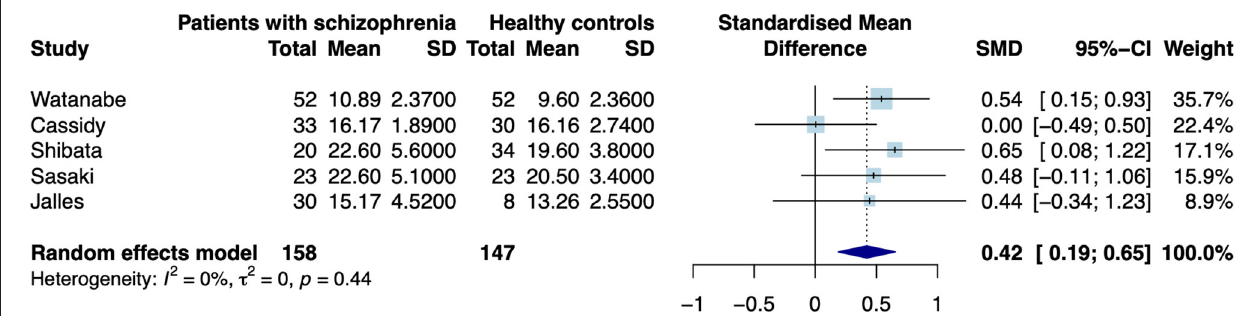
FIGURE 2 | Forest plot of random effects analysis of mean group differences. Filled squares represent estimates per study and whiskers represent confidence intervals. Diamonds represent the point estimates with confidence intervals for an overall estimate in subgroups and the overall pooled effect across all studies.